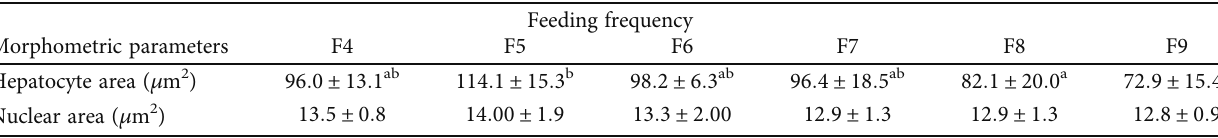
∗ Values without letters or with the same letters, which are on the same line, indicate that there was no signi fi cant di ff erence ( p > 0 : 05 ), whereas those with di ff erent letters indicate a signi fi cant di ff erence ( p < 0 : 05 ). F4: Fed 4 times a day; F5: fed 5 times a day; F6: fed 6 times a day; F7: fed 7 times a day; F8: fed 8 times a day; F9: fed 9 times a